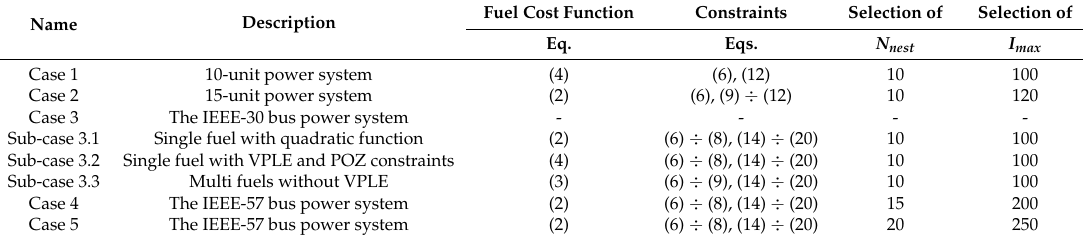
Table 1. Description of five main employed power systems and the selections of control